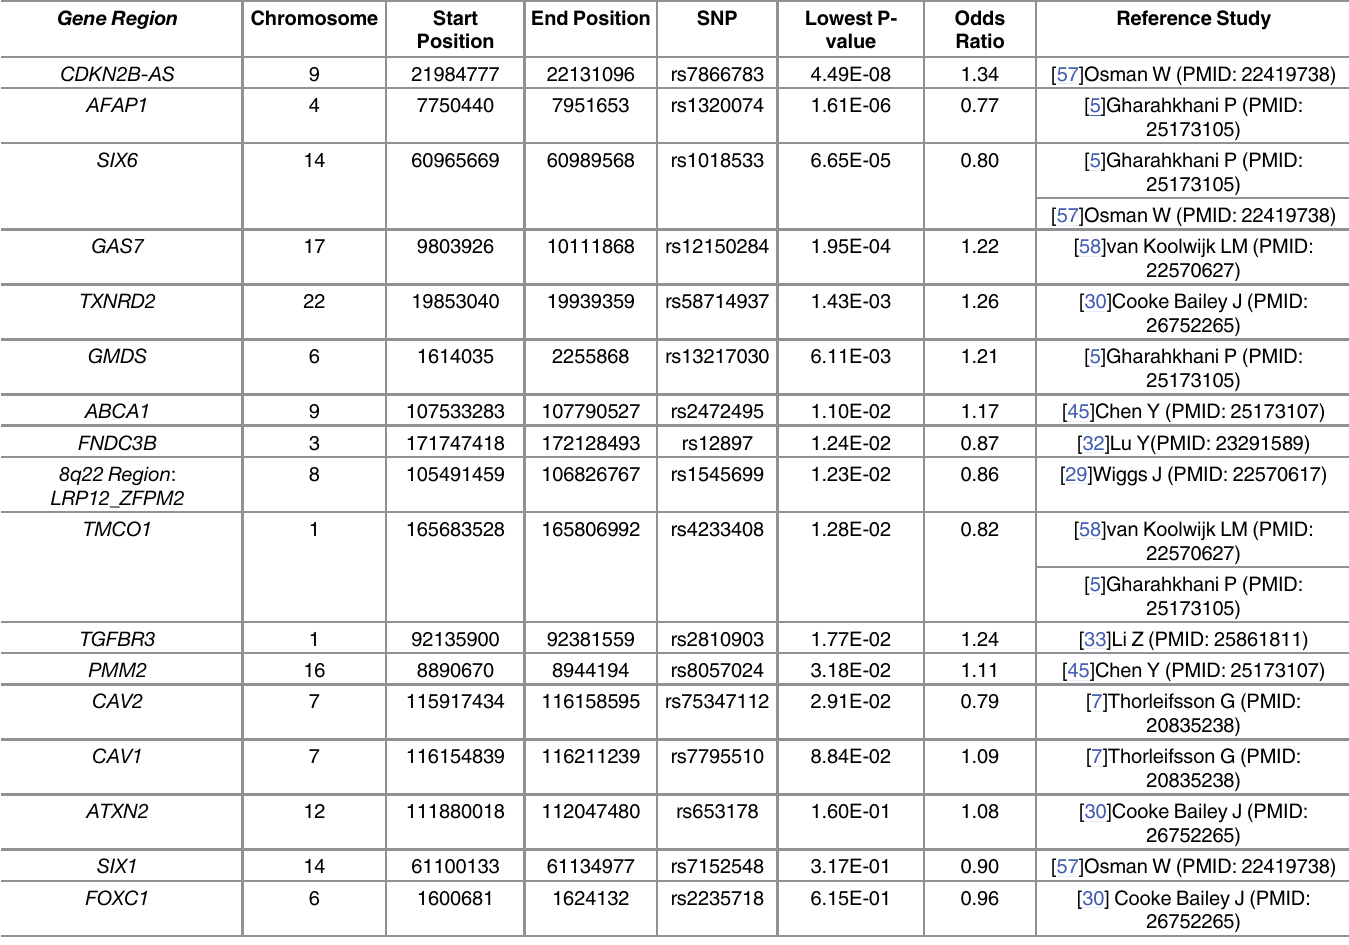
Table 1. Results from GWAS analysis, showing previously reported gene regions that are known to be associated with glaucoma; the lowest p- value of the gene region in eMERGE GWAS analysis for glaucoma is reported. Gene Region